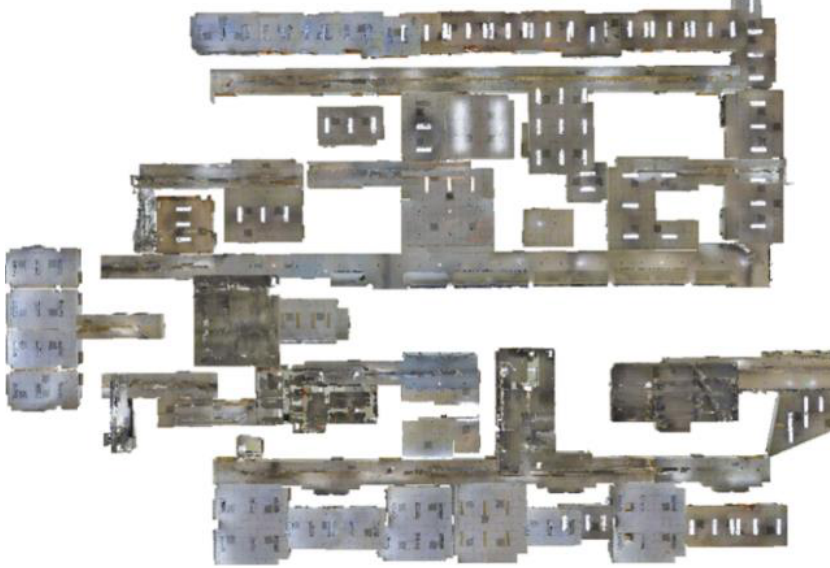
Figure 9. Area 5 of the S3DIS datasets.